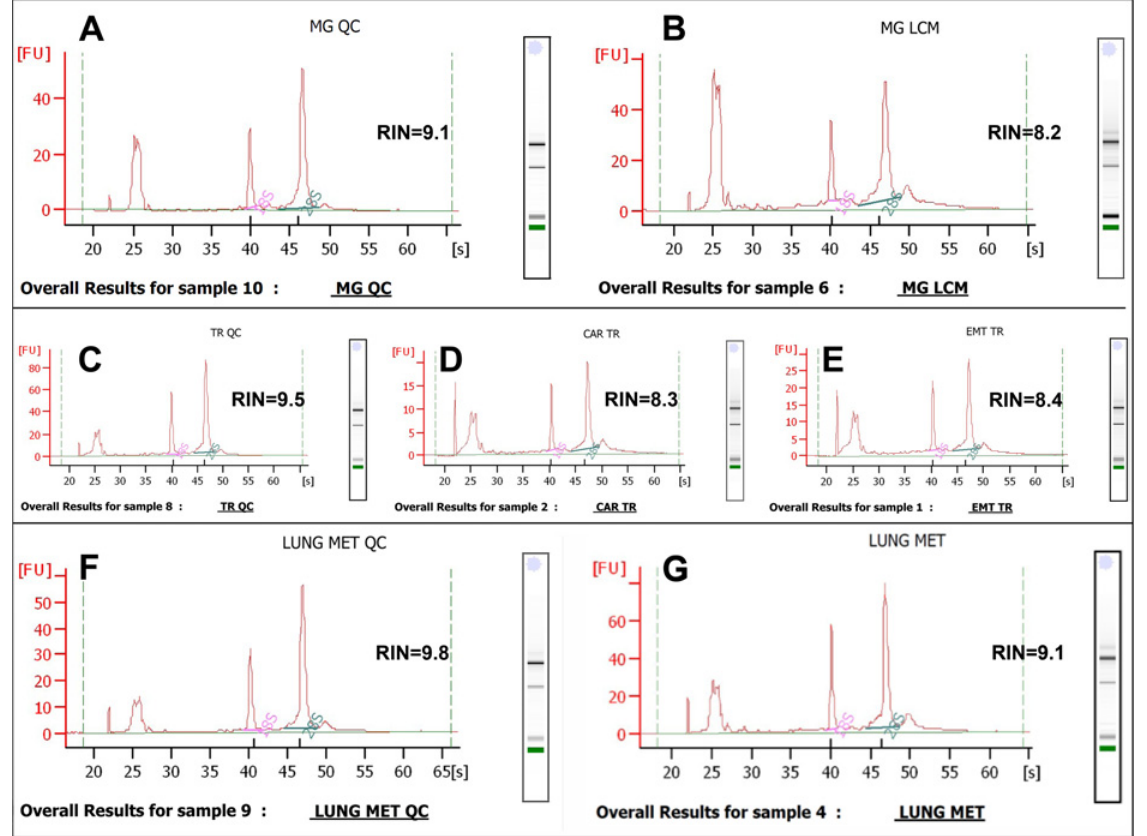
Fig 3. Representative Agilent electropherograms of high quality RNA retrieved from the control sections and corresponding LCM targets. (A, C, F) Frozen section of normal mammary gland (A), primary mammary tumor (C) and lung metastasis (F) placed directly in lysis buffer for RNA extraction. (B) LCM sample of normal mammary tissue; (D, E) LCM cell populations of primary mammary tumor: carcinoma (D) and EMT (E); (G) LCM sample of lung metastasis.